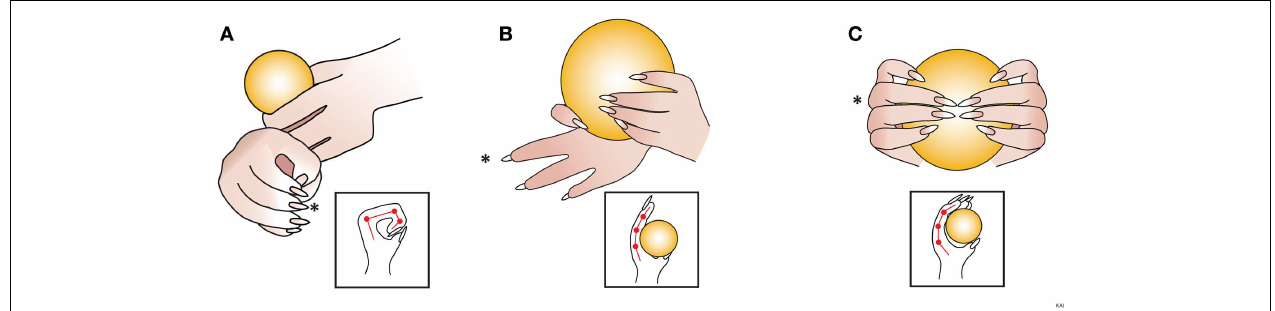
to the shape of the cereal. (C) Partially extended, adaptable – digits are partially extended with joint angles between 160 ° and 90 ° ; in addition, these digits CONFORM to the shape of the cereal. Diagrams within the squares are observing the impaired forepaw, depicting digits 1 and 3 (*), from above. (Revisions of the IBB scale from the JoVE 2010 version are highlighted in italics.)